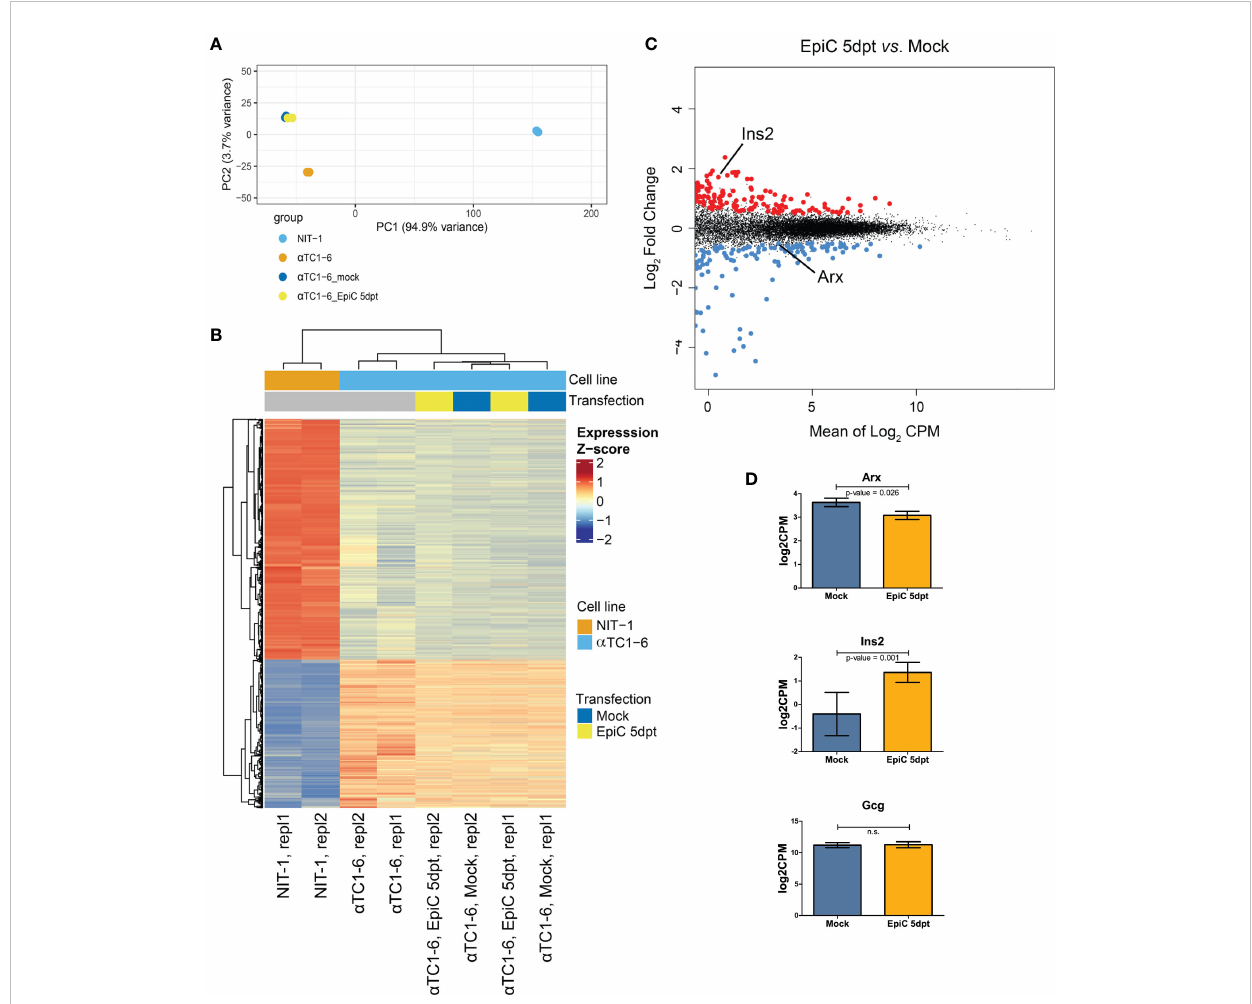
FIGURE 6 Transcriptomic analysis of Mock and EpiC a TC1-6 cell at 5 th post-transfection day. (A) PCA of RNA-seq data of a TC1-6 (N=2, orange), NIT-1 (N=2, blue), Mock (N=2, dark blue), and EpiC transfected cells (N=2, yellow), describing >95% of the transcriptional variability at the fi rst